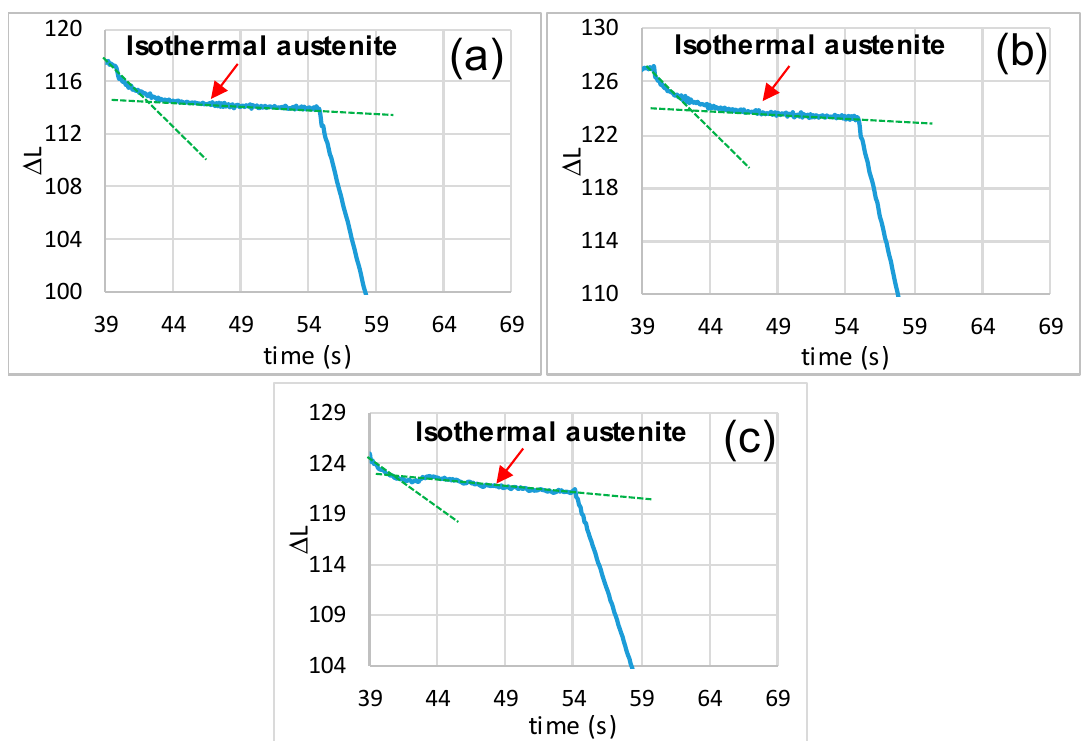
Figure 6. Δ L vs. time curves showing the variation in slopes during the isothermal intercritical annealing previous to isothermal bainitic treatment conducted at: ( a ) 425 s; ( b ) 450 and ( c ) 475 °C.